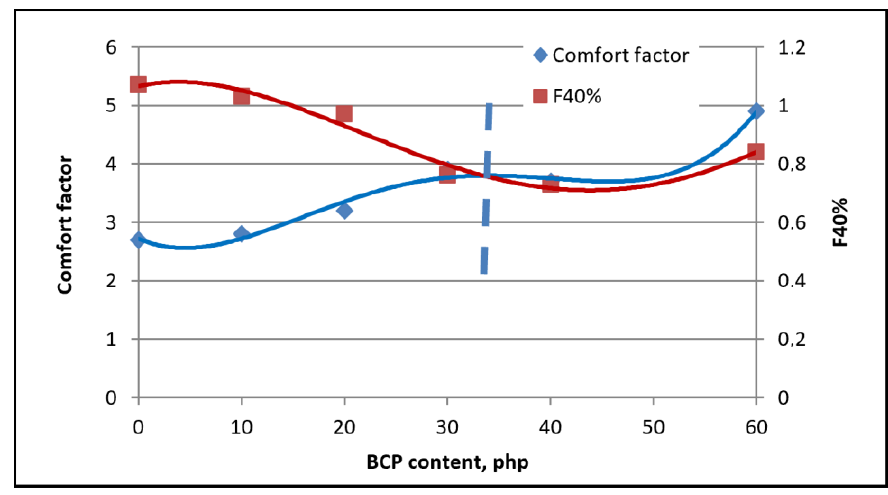
Figure 15. Results of analysis of strength properties determined during foam compression.